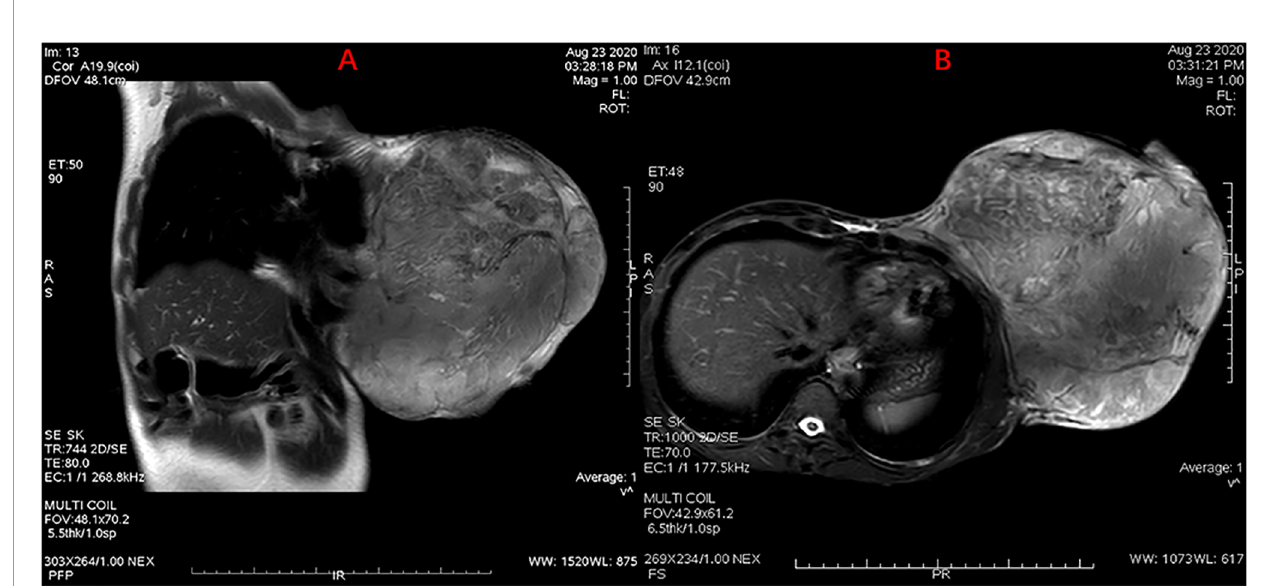
FIGURE 1 | MRI scan showing a giant mass in the left breast with skin ulceration. Without chest wall in fi ltration or axillary lymph node metastasis were observed. (A) Sagittal MR scanning, (B) Horizontal MR